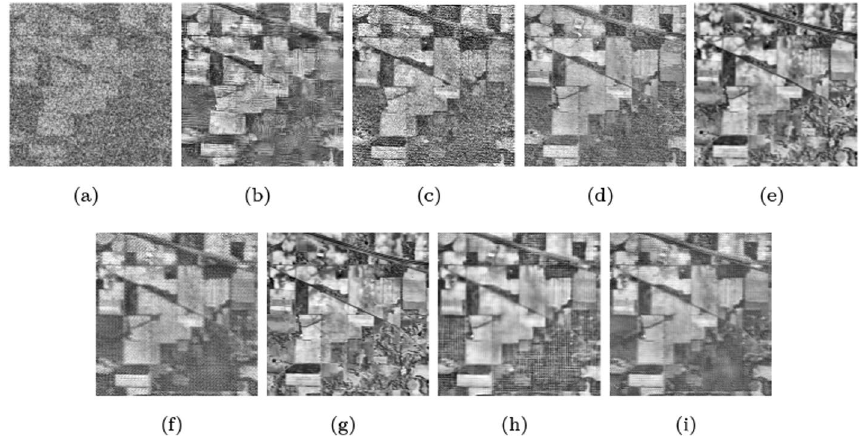
Fig. 6 Band 219 of the Indian Pines dataset before and after denoising via the different methods: a Original image; b BM4D; c LRMR; d NAILRMA; e LLRGTV; f MTGSNMF; g SSTVSSLR; h HSI-SDeCNN; i SRGLR (proposed)